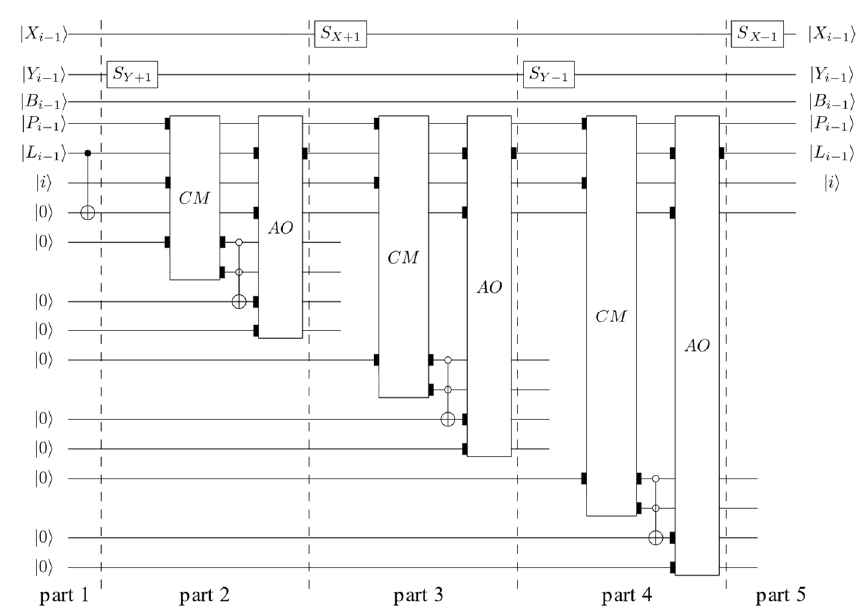
Figure 16. The quantum circuit of Equation (4).